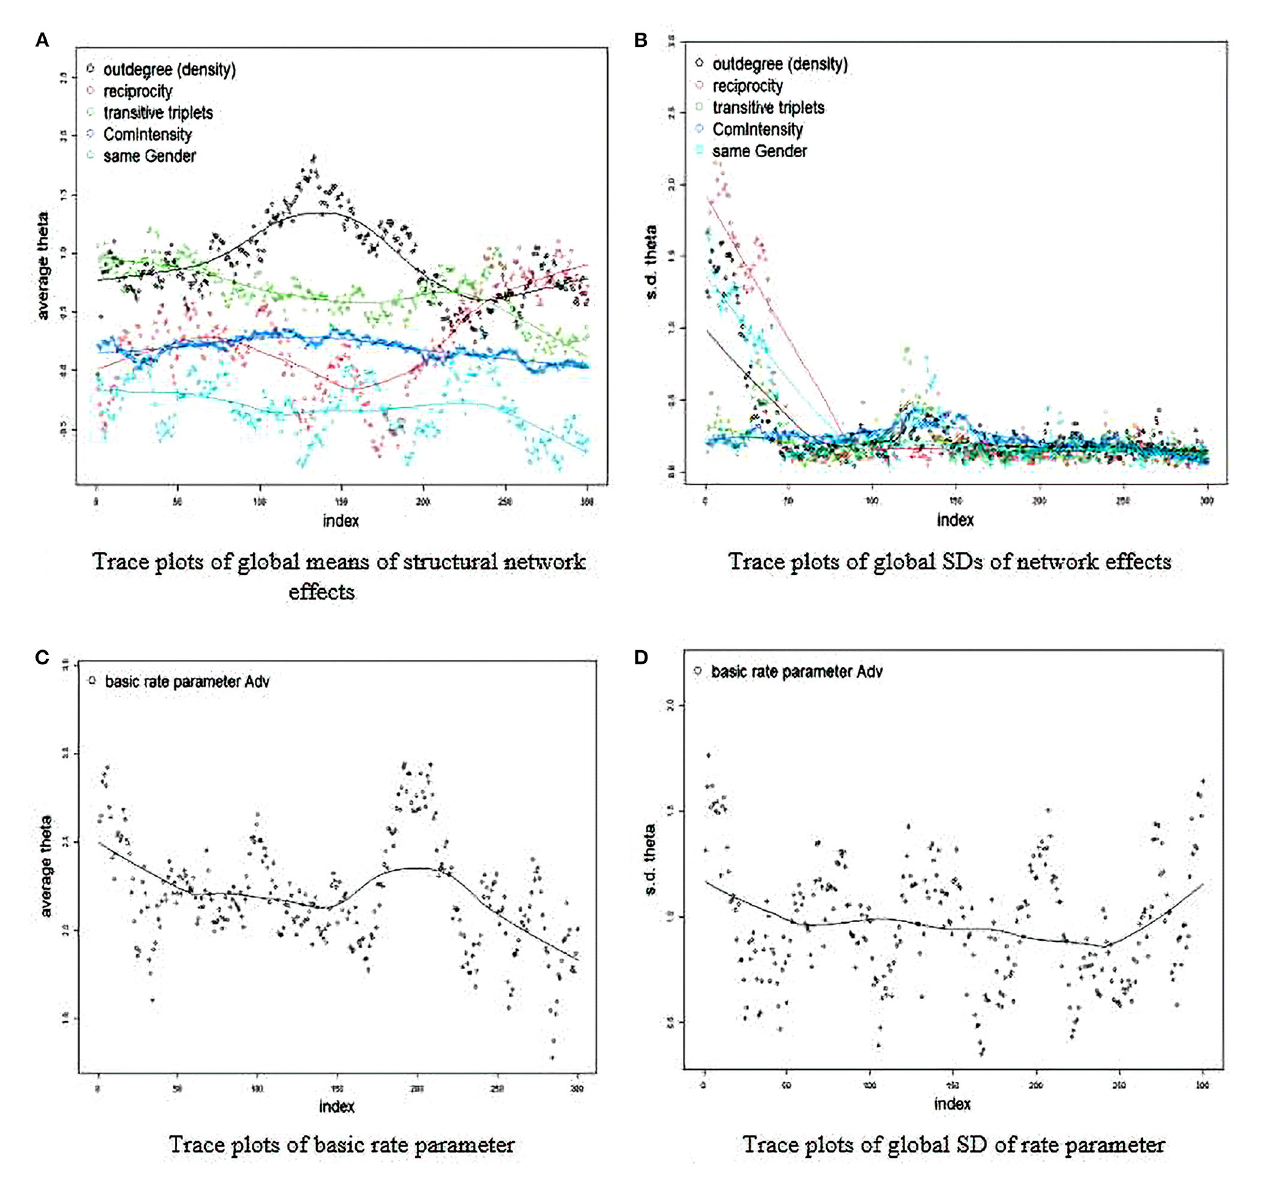
FIGURE1 (A–D) Trace plot for convergence diagnosis. Initial estimation (bad convergence). SD, standard deviation; Adv, name of key network; Theta, estimated coefficient; Index, iteration in estimation chain.